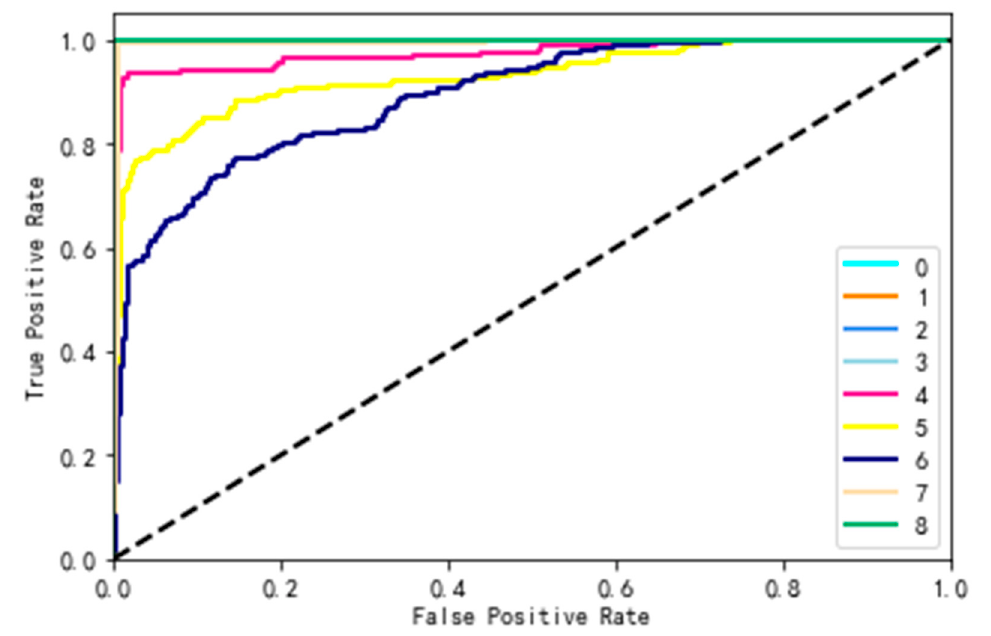
Figure 11. Mutianyu_Great_Wall receiver operating characteristic curve.